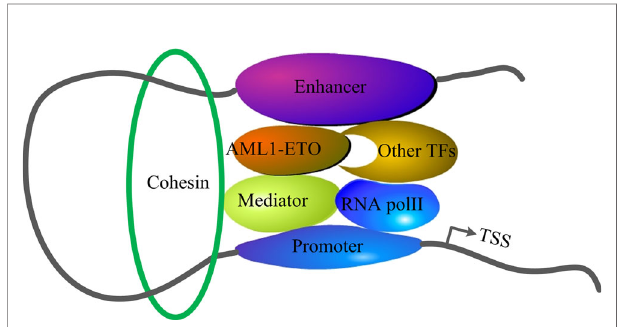
FIGURE 3 | Interactions of cohesin and